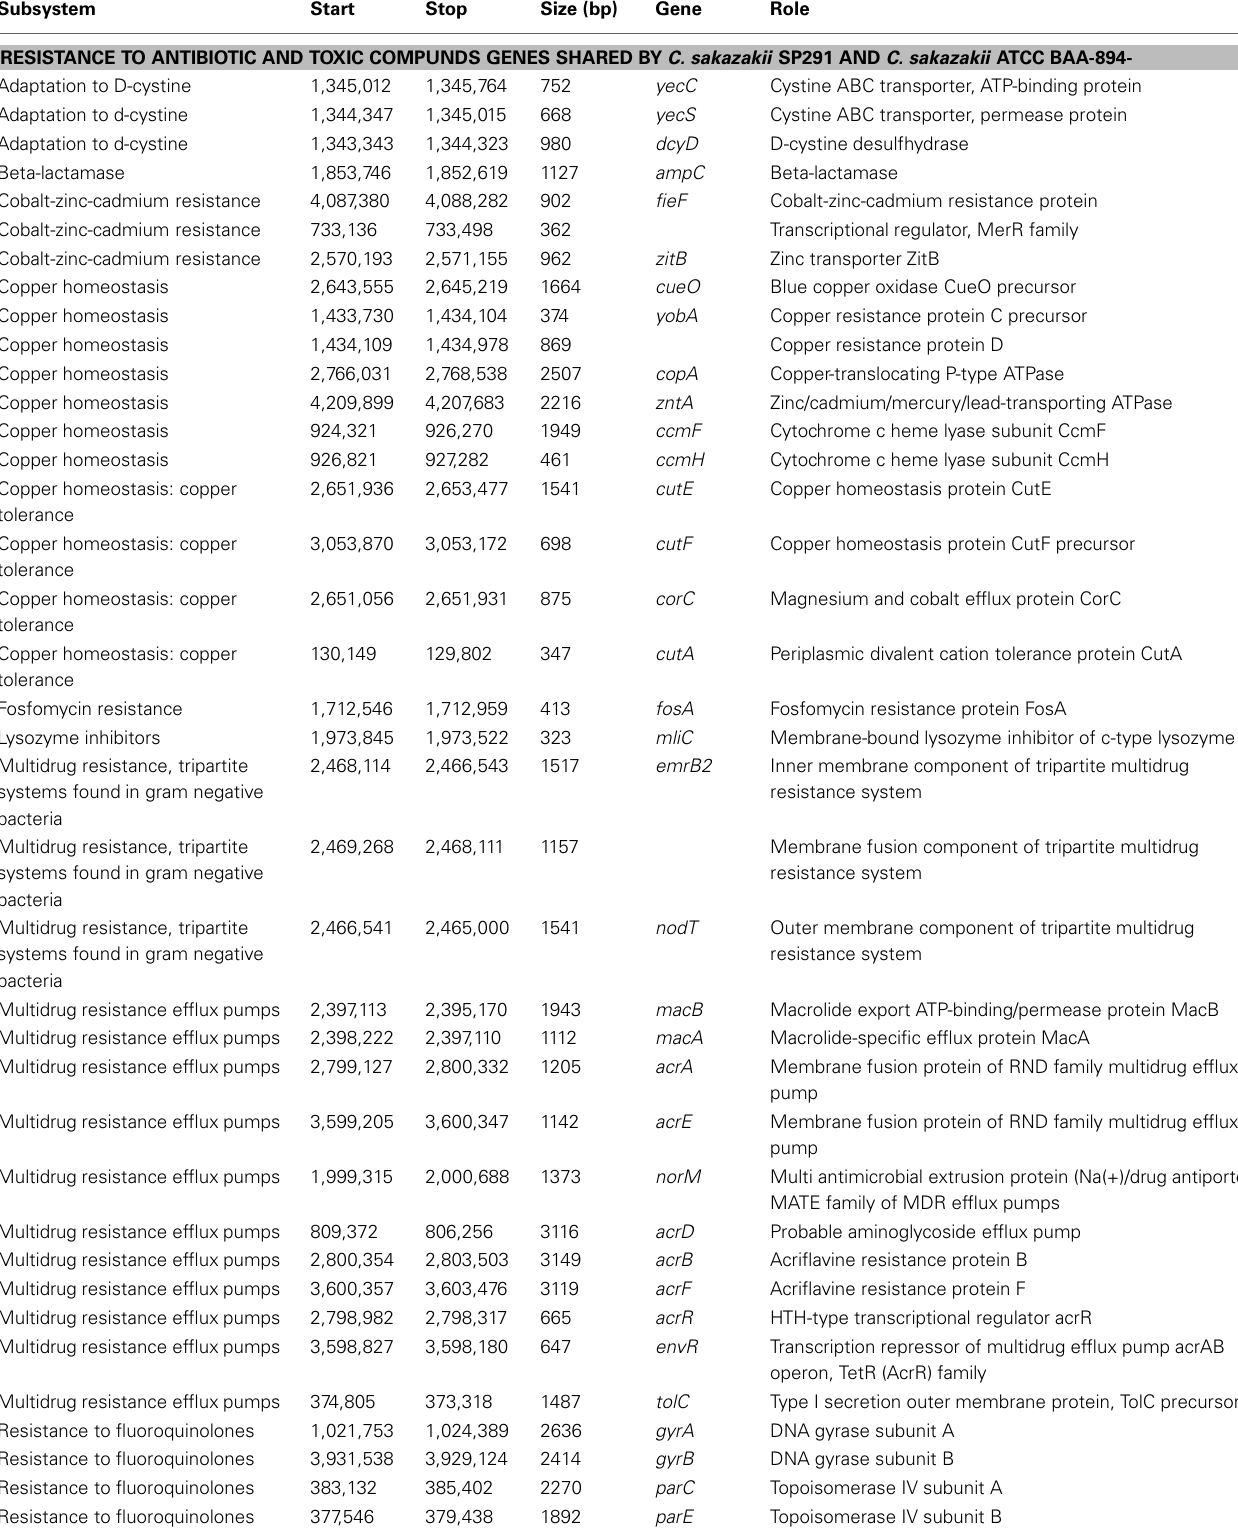
Table 6 | Genes related to resistance to antibiotics and toxic compounds annotated in C. sakazakii SP291 and C. sakazakii ATCC BAA-894.